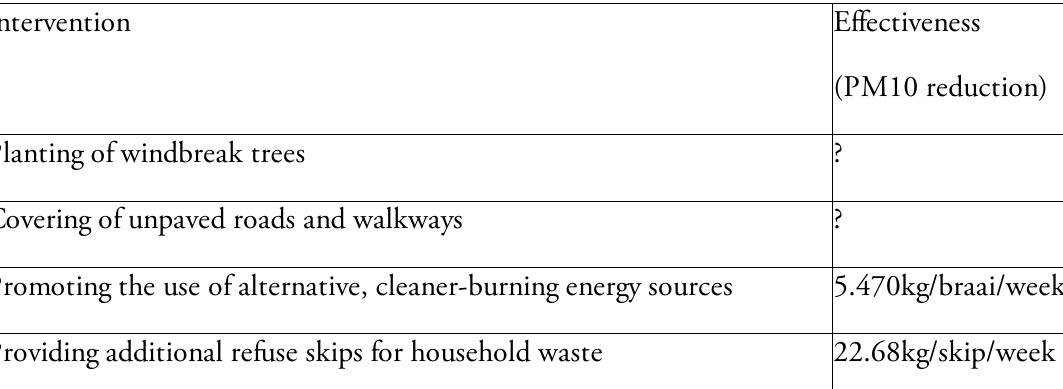
Table 12: The effectiveness of the PM10 reduction interventions